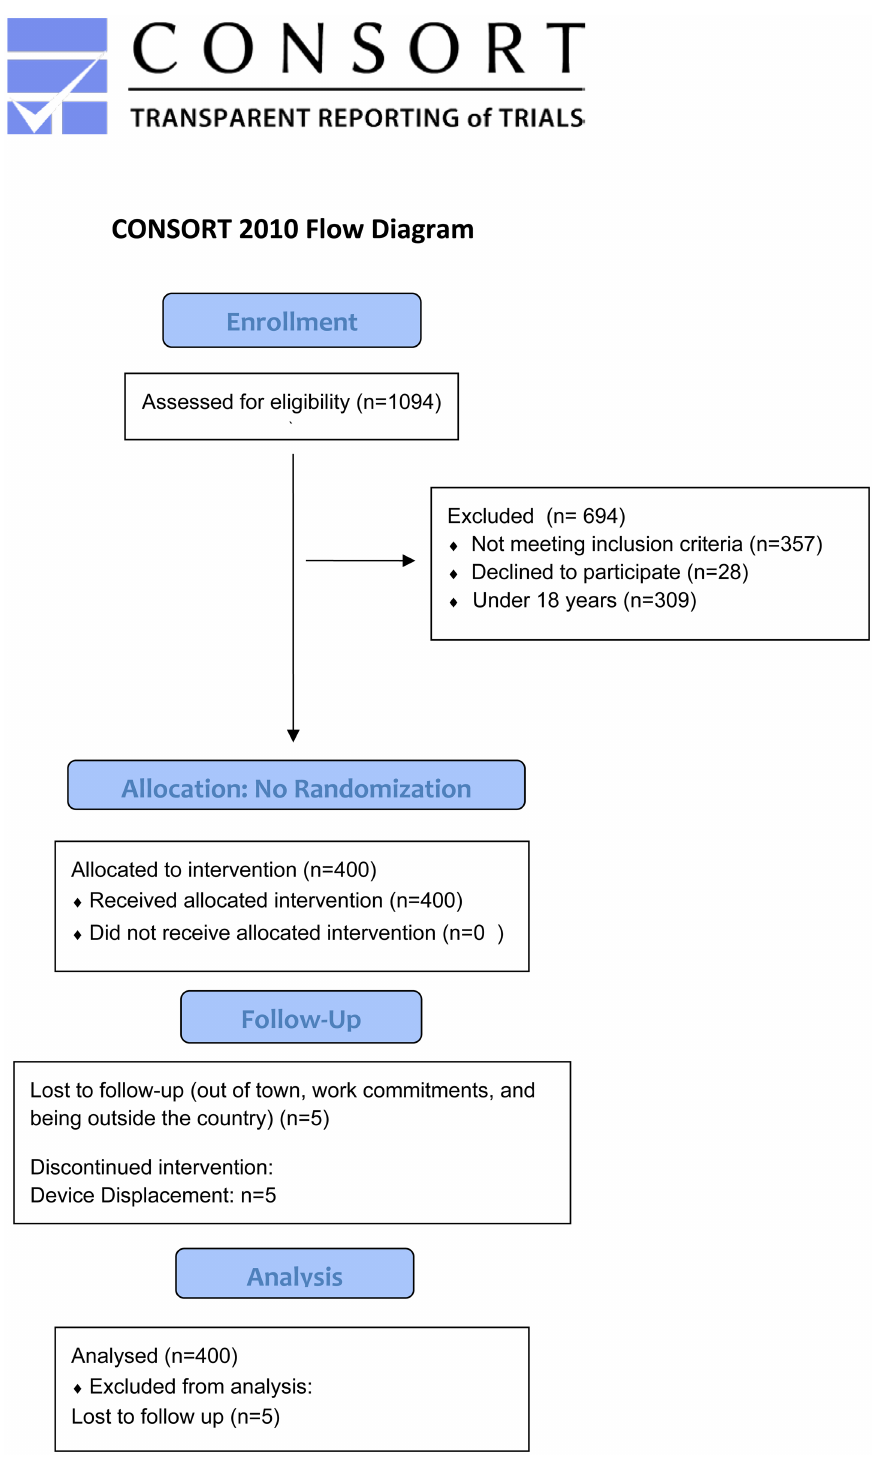
Fig 1. CONSORT flow